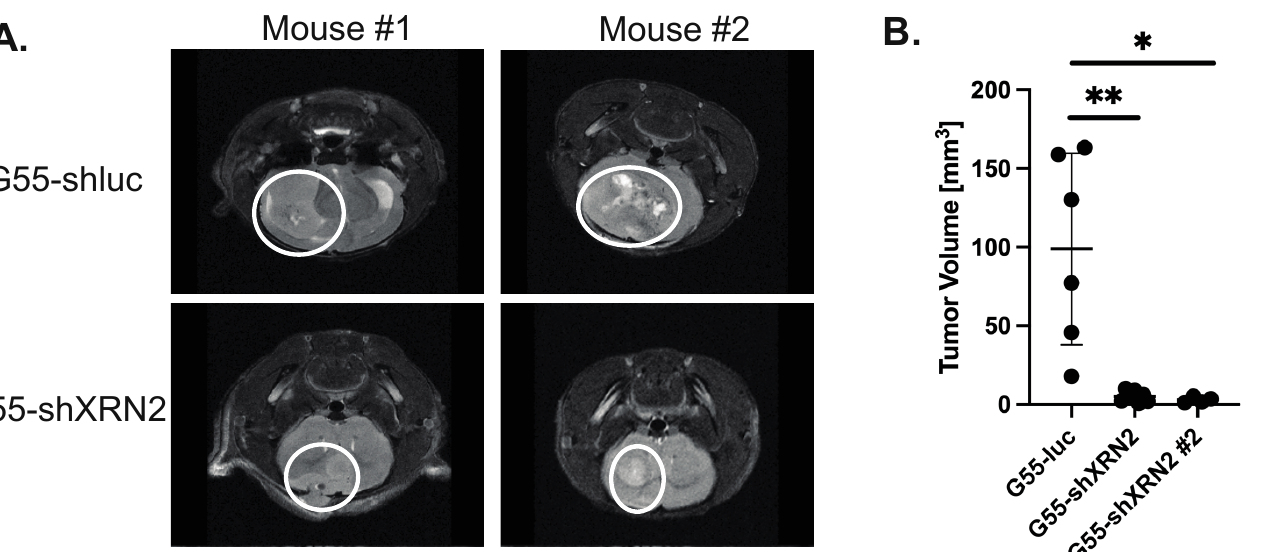
Figure 4. Loss of XRN2 results in decreased tumor volume in vivo. ( A ) Magnetic resonance imaging was used to detect control (G55-shluc) and XRN2-deficient (G55-shXRN2) tumors in mouse brains. ( B ) Quantitation of tumor volumes obtained from control (G55-shluc) and two unique XRN2-deficient (G55-shXRN2 and G55-shXRN2 #2) G55 cell lines. * = p -value ≤ 0.05, ** = p -value ≤ 0.01. The Students t -test was used for statistical analysis.